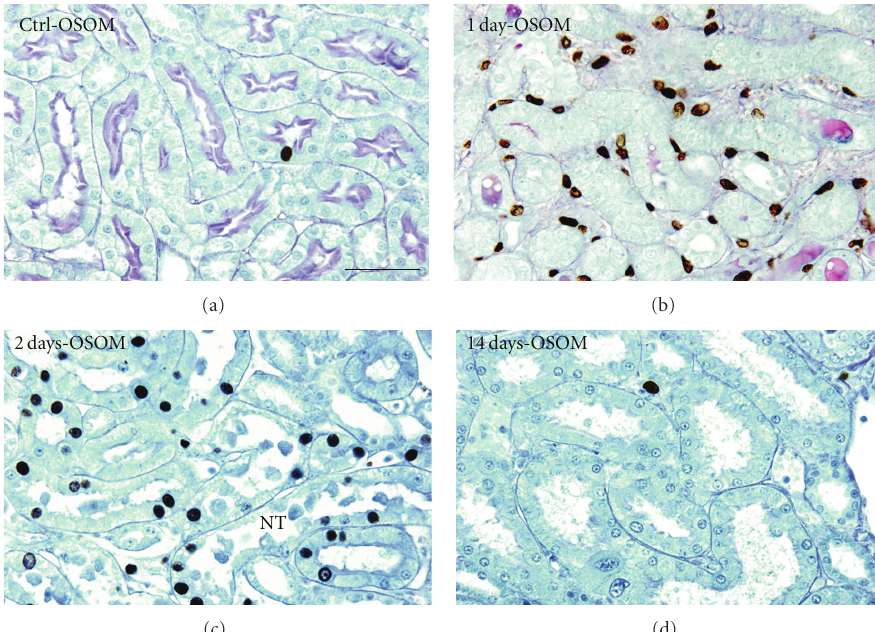
Figure 2: Immunohistochemical demonstration of BrdU-containing nuclei of S-phase cells in OSOM of control kidneys (a) or after reperfusion (b, c, d). S3 tubules of controls are characterized by a very low cell turn-over (a). In contrast cell proliferation increases dramatically in injured tubules two days after ischemia (c). The density of interstitial BrdU-positive cells is high in the periphery of necrotic tubules (NT) 1 and 2 days after ischemia (b, c) but appear similar to controls 2 week after ischemia (d). Scale bar. 30 μ m: (a, b); 25 μ m: (c, d).